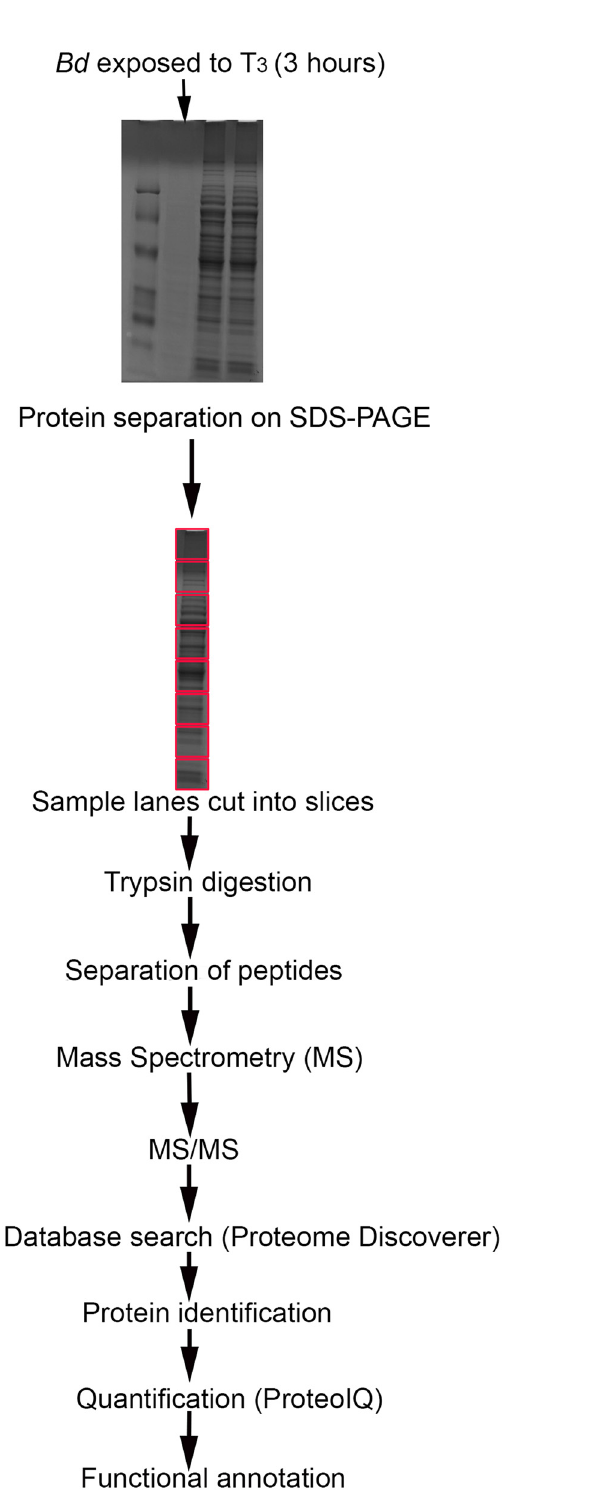
Fig 1. Schematic illustration for the proteomics study to profile total proteins in Batrachochytrium dendrobatidis following exposure to T 3 . Red boxes show regions where each sample lane of the gel was cut into slices for peptide